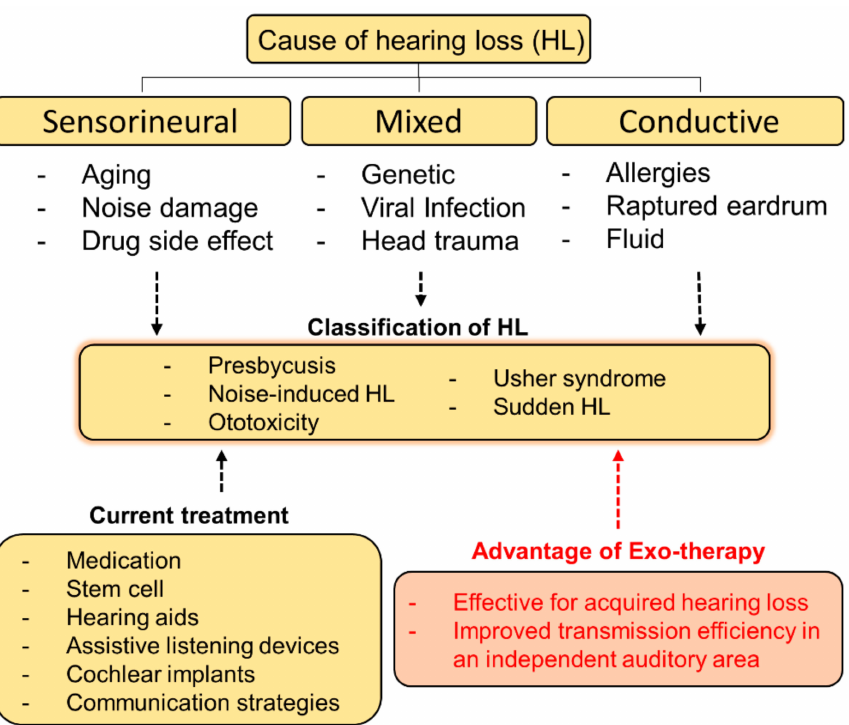
Figure 3. A schematic diagram of causes, classification, and current treatments for hearing loss. The approach direction of exosome-based therapy (exo-therapy) for applying to hearing loss was described and its advantages were